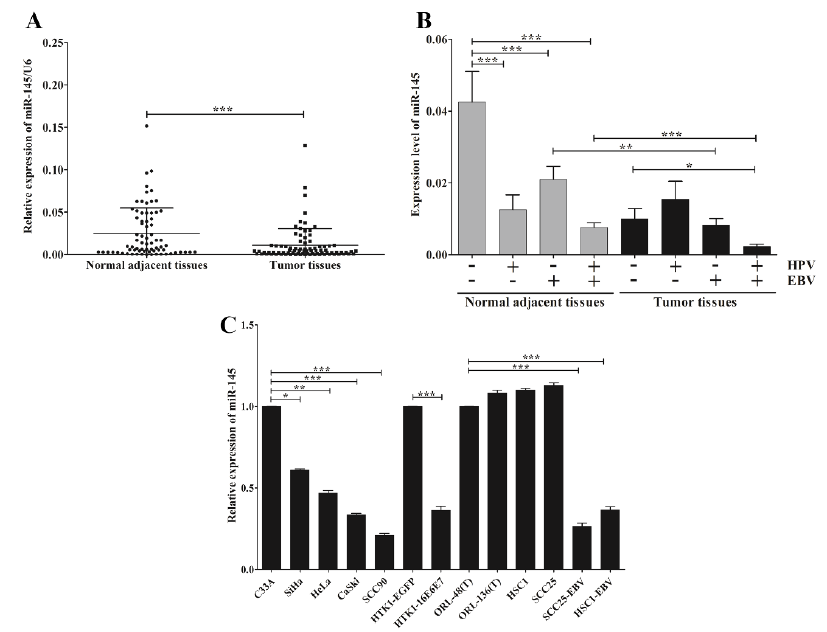
Figure 3. EBV infection alone or jointly with HPV associates with the down-regulation of miR-145 in OSCC. The expression of miR-145 in OSCC tissues ( A ) and OSCC tissues with or without EBV and/or HPV ( B ) and in cancer cell lines ( C ) was examined by qRT-PCR. *: p < 0.05; **: p < 0.01; ***: p <